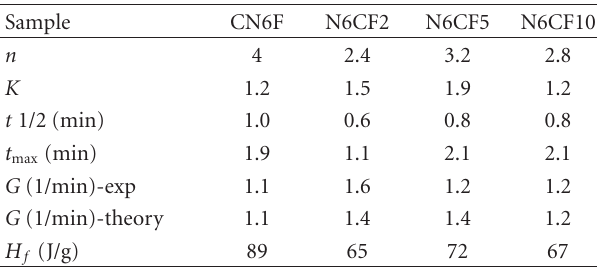
Table 3: Crystallization parameters for di ff erent film samples.